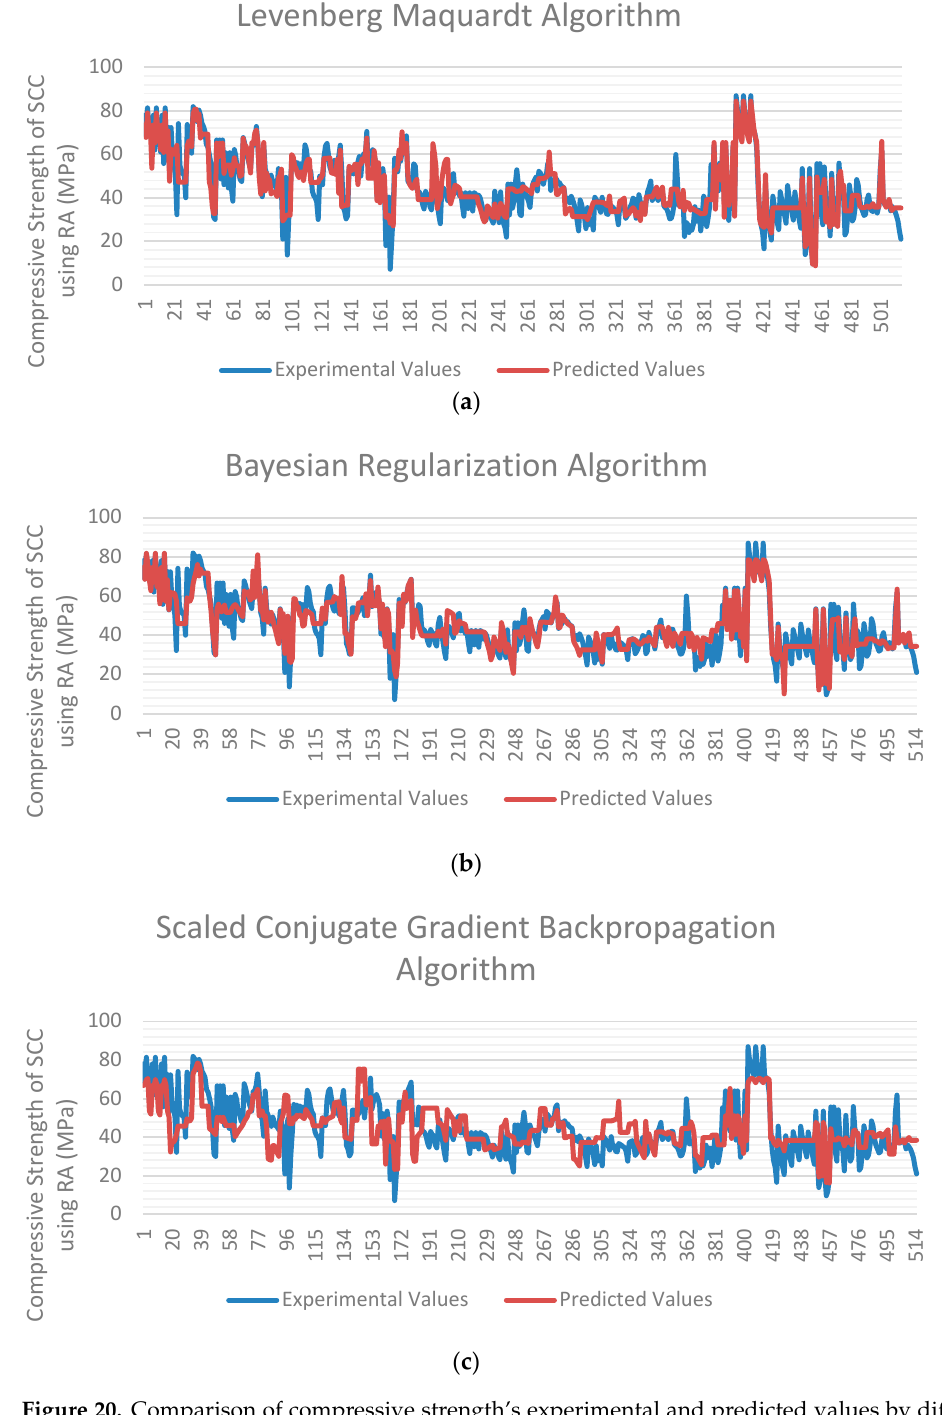
algorithms employed in ANN: ( a ) LM, ( b ) BR, and ( c ) SCG.